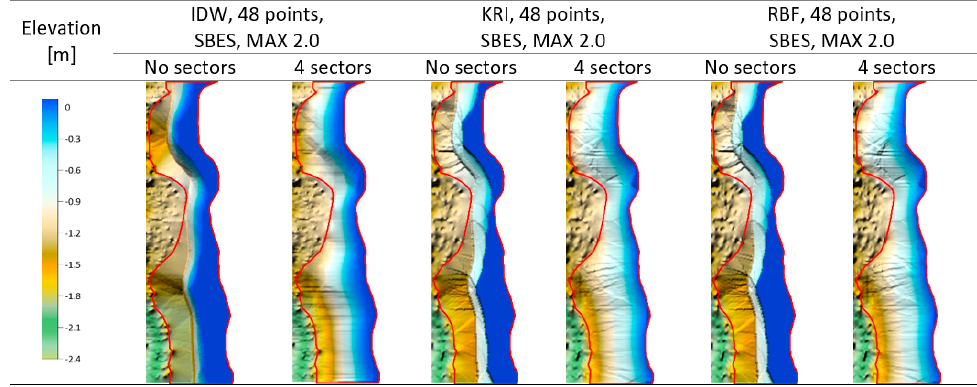
Figure 7. Comparison of surface modeling in the area with a lack of data using sectorless and sector search options.